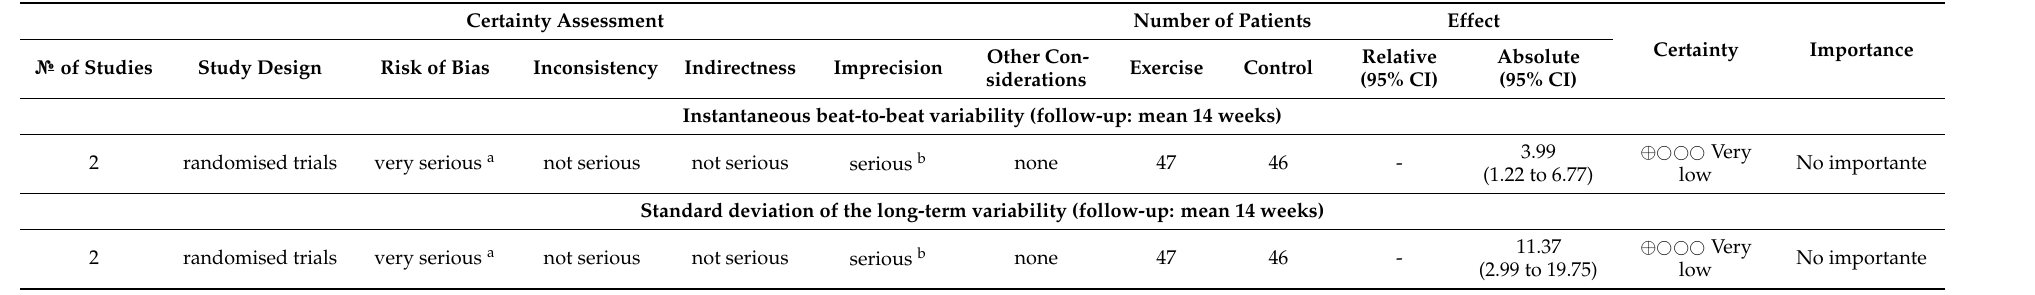
Table 2. Summary of findings and certainty assessment–intervention (exercise vs.